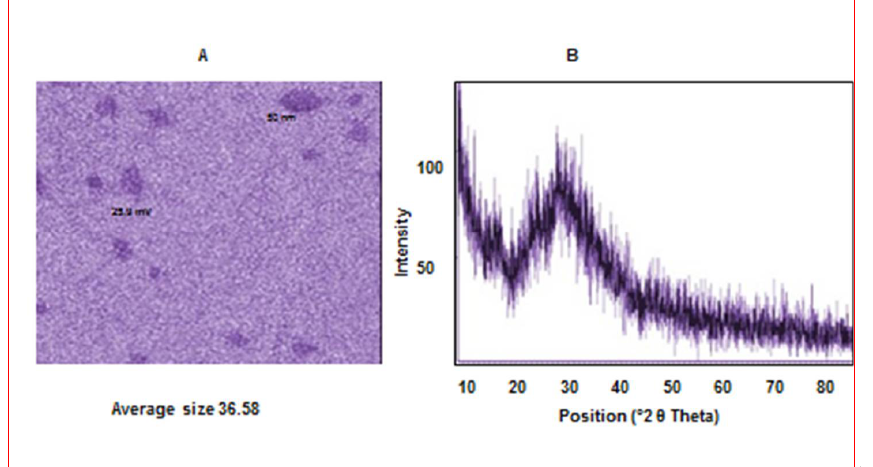
Figure 4. Characterization of physic chemical synthesized chitosan nanoparticles (CS-NPs). ( A ): X-ray diffraction (XRD) pattern indicating a morphism nature of chitosan particle. ( B ): TEM histogram showing chitosan nanoparticles (CS-NPs) a pseudospherical shape with average size of 36.59. Comparing the effect of different concentrations of (CS-NPs) on regeneration response and production of PVY-free plants indicated that increasing the concentration of (CS-NPs) from 100 to 250 mg L −1 in the culture medium resulted in positive effects on mg L −1 (CS-NPs) showed higher growth and developed into complete plantlets. Excellent growth and regeneration shoots were obtained at 250 mg L −1 ( Figure 6a, b). At the highest